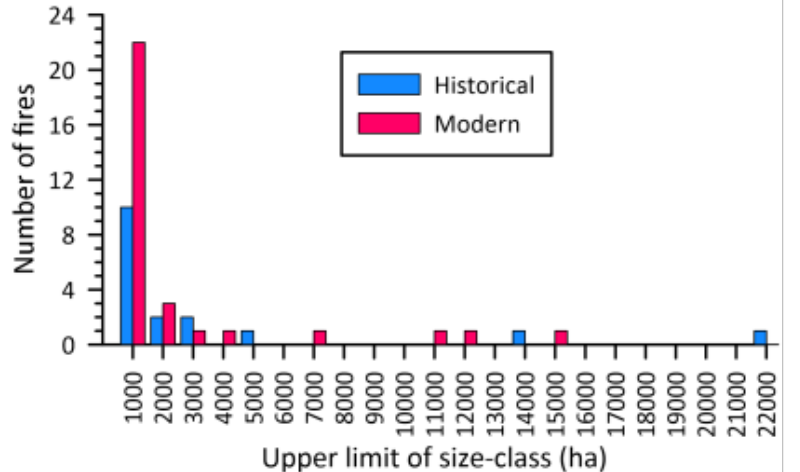
Figure 4. Comparison of distributions of modern (1980–2020) and historical (1850–1909) sizes of the moderate- to high-severity parts of wildfires.